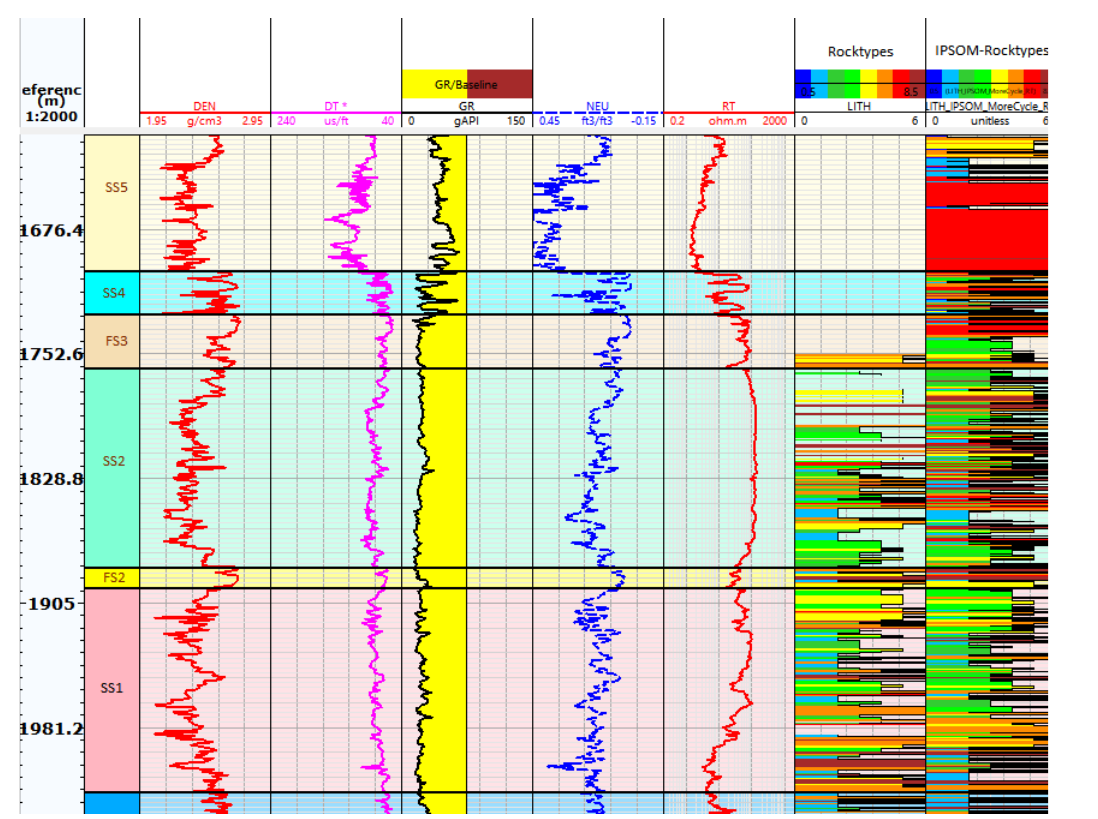
Figure 9. The above graphic shows a log facies of the E11-2 plot. The 6 rock types were computed using IPSOM probabilized self-organizing method. The track on the right (Column 8) is color-coded for facies 1 to 6. The input logs are bulk density, compressional slowness, gamma-ray, neutron porosity, and resistivity.